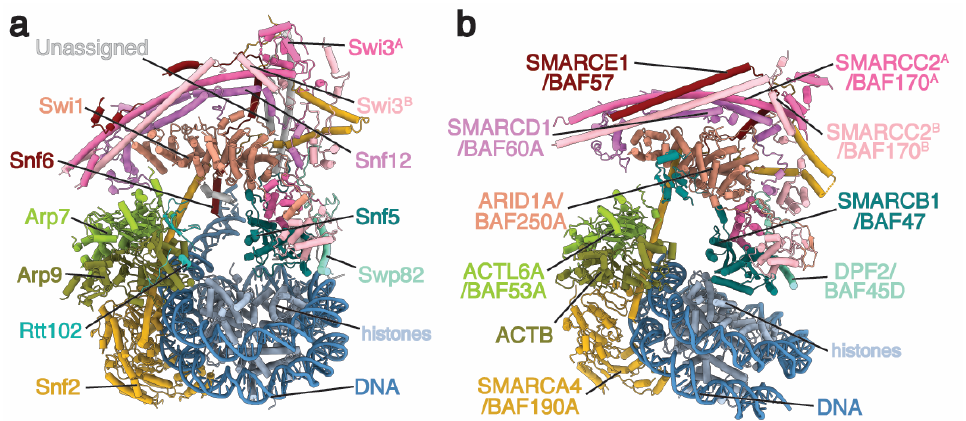
Figure 1. Comparison of switch/sucrose nonfermentable (ySWI/SNF) and human BAF (hBAF) complexes. Structural models of ( a ) ySWI/SNF (PDB 6UXW) and ( b ) hBAF (PDB 6LTJ) are shown in a similar orientation by superimposing orthologous subunits in a pairwise manner. Orthologs are colored the same between models. “/” separates alternative names for individual subunits in hBAF.